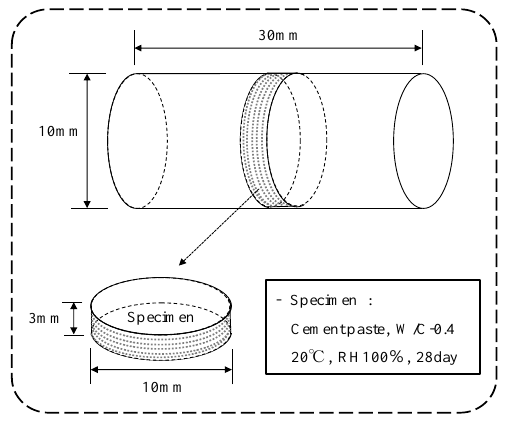
Figure 3. Schematic of the preparation of the cement samples.